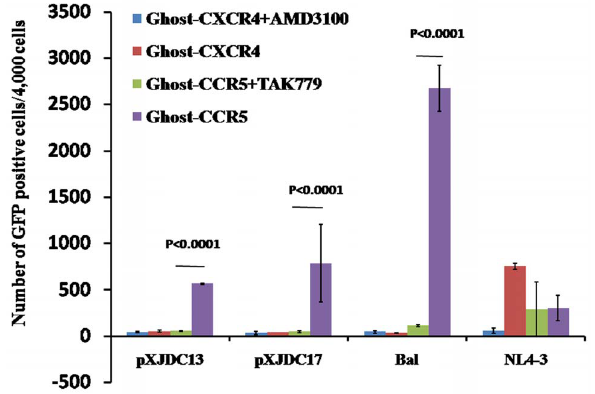
Figure 4. Tropism of clone derived viruses and their parental isolate. Ghost-CXCR4 and Ghost-CCR5 cells were treated in the absence or presence of the following inhibitors one hour prior to infection: CXCR4 antagonist AMD3100 at 2.5 m M, or CCR5 antagonist TAK-779 at 20 m M. Approximately 4,000 cells for each sample were collected to perform flow cytometry assay for GFP signals to determine the number of HIV infected cells. The mean numbers of GFP-positive cells are shown with standard deviations from three separate